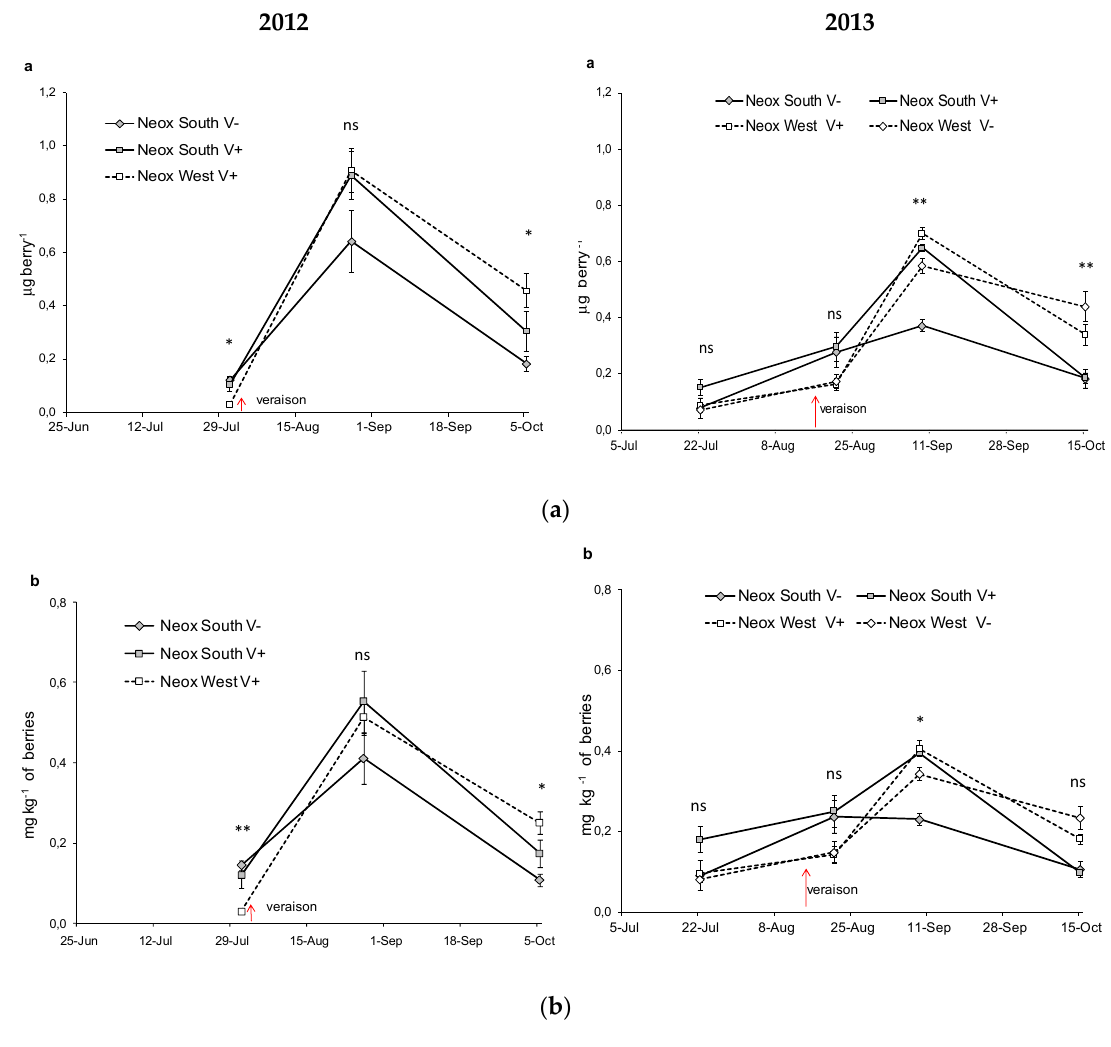
Figure 4. Seasonal changes of neoxanthine as µ g berry − 1 ( a ) and mg kg − 1 of berries ( b ) in Nebbiolo grapes in 2012 (on the left) and 2013 (on the right), as a function of vine vigor and vineyard aspect. Averages ± standard error (n = 3). * p < 0.05, ** p < 0.01 indicate the significance of differences among treatments.